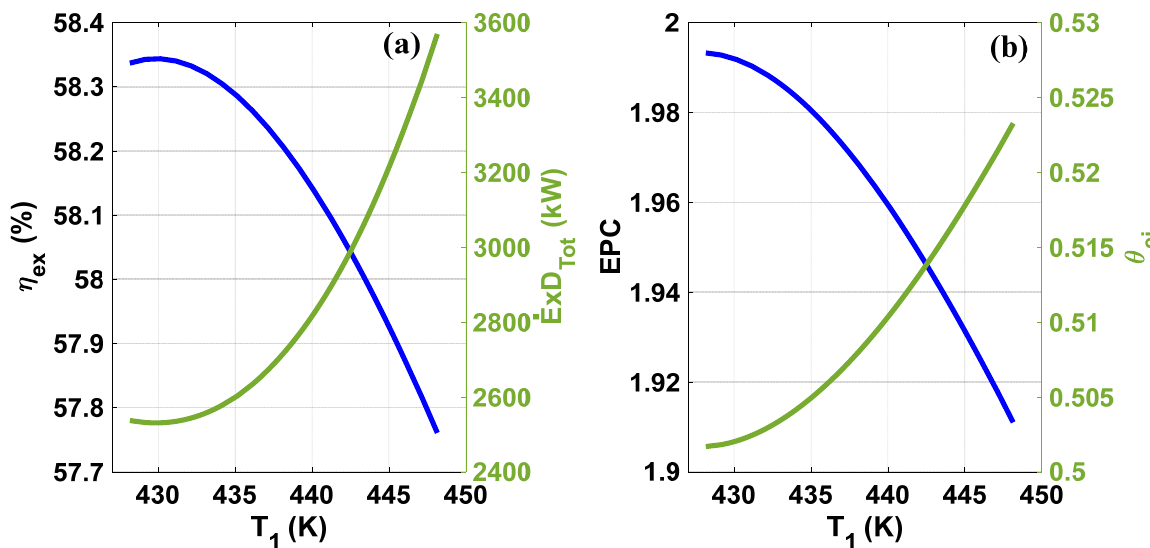
Figure 5. ( a ) The exergy efficiency and destruction variations with the inlet temperature of the production well. ( b ) The exergetic performance criteria and exergo ‐ environmental impact index variations with the inlet temperature of the production well.